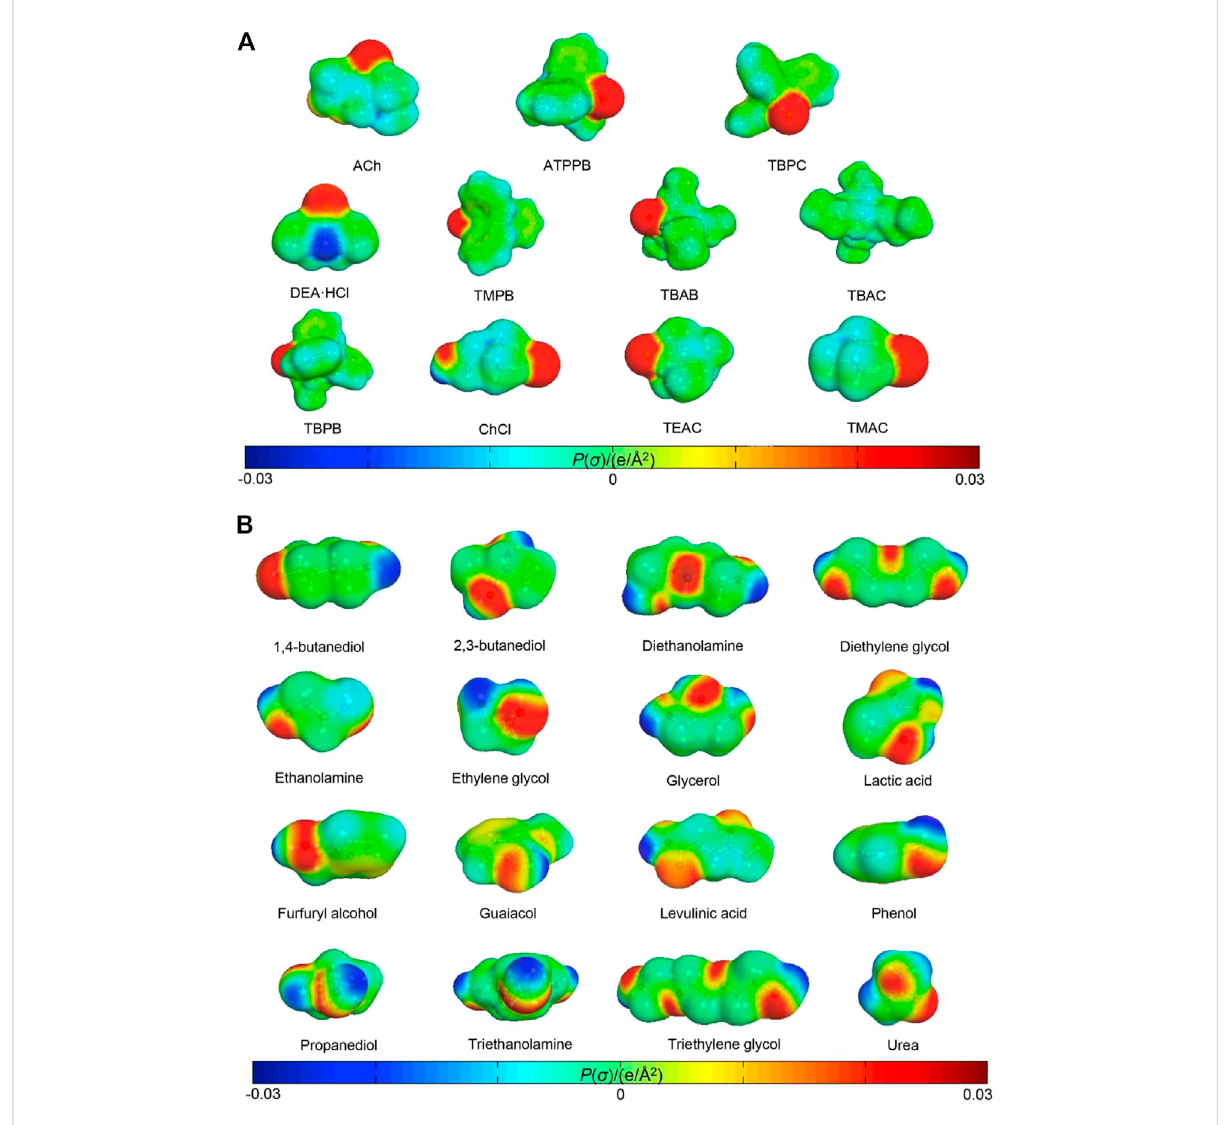
FIGURE 13 Optimized (A) HBA and (B) HBD structures with COSMO surfaces (Wang J et al.,